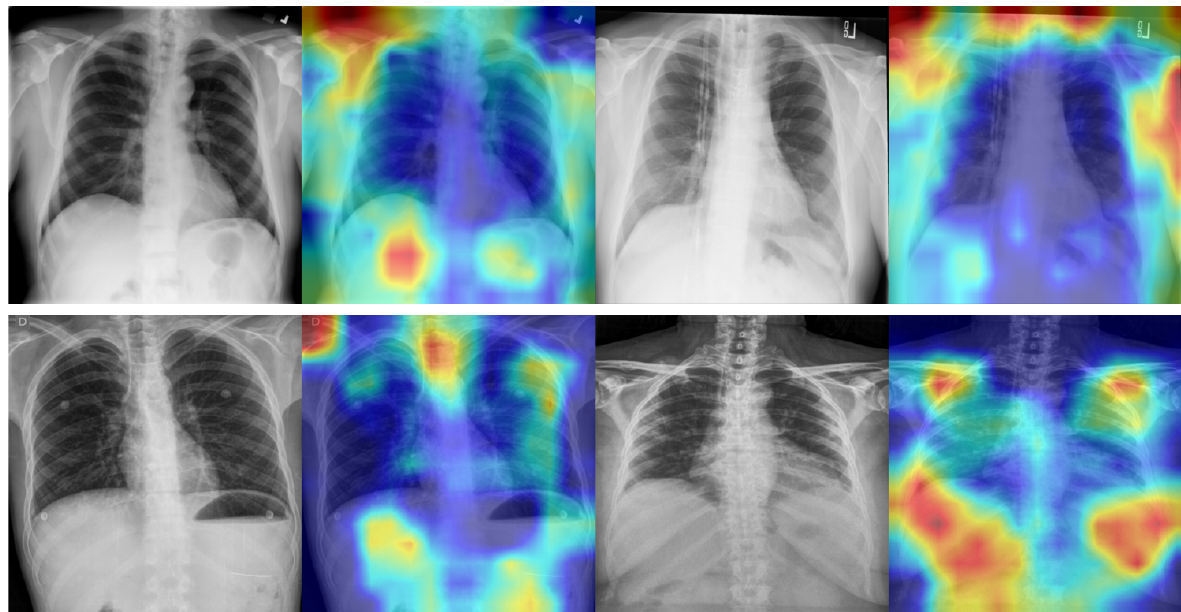
Figure 8. Grad-CAM visualization of Bit-M. First row is SARS-CoV-2-negative patient cases; second row is SARS-CoV-2- positive patient cases. Red regions correspond to a high score for class. All models of chest X-ray images yielded accurate